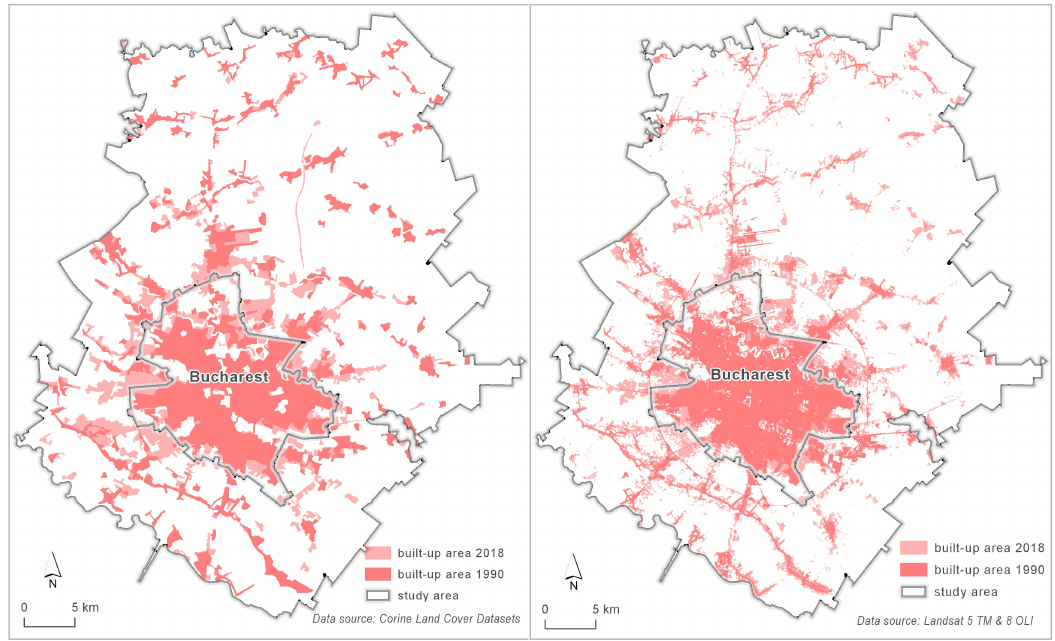
Figure 4. Built-up area coverage in the Bucharest–Ilfov Region for both time references on CLC ( left ) and Landsat classification ( right ).